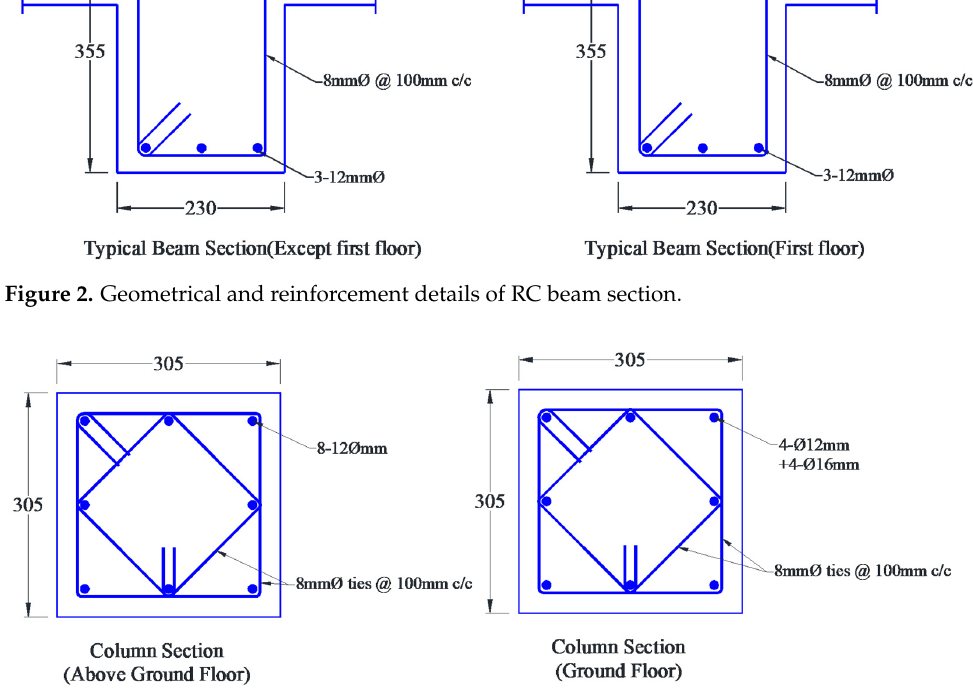
Figure 3. Geometrical and reinforcement details of column section.